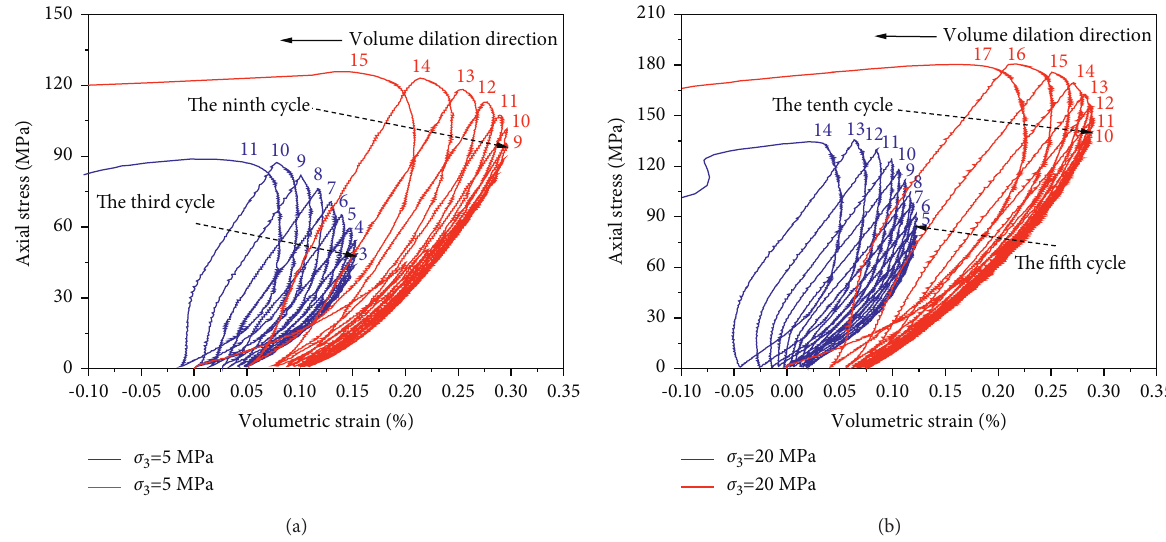
Figure 6: Typical volumetric strain of phyllite (blue denotes saturated phyllite and red denotes dry phyllite; σ